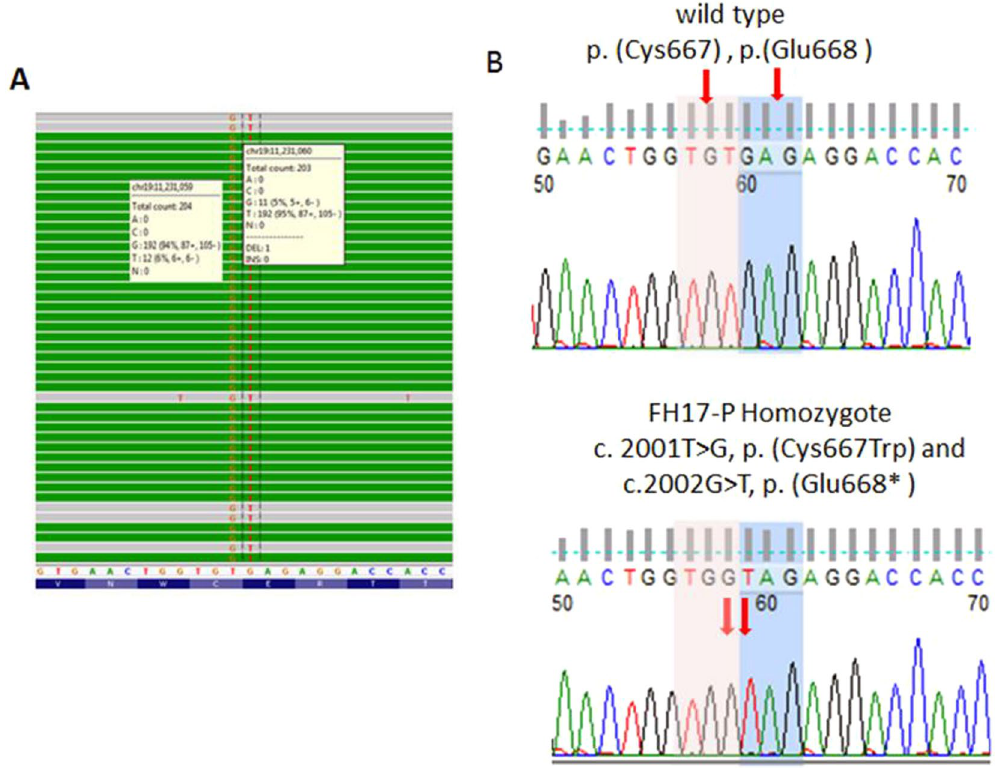
Figure 3. LDLR novel mutation p.(Glu668 * ) sequencing data. ( A ) NGS sequencing reads alignment using Integrated Genomics Viewer (http://software.broadinstitute.org/software/igv/) for proband FH17-P reports